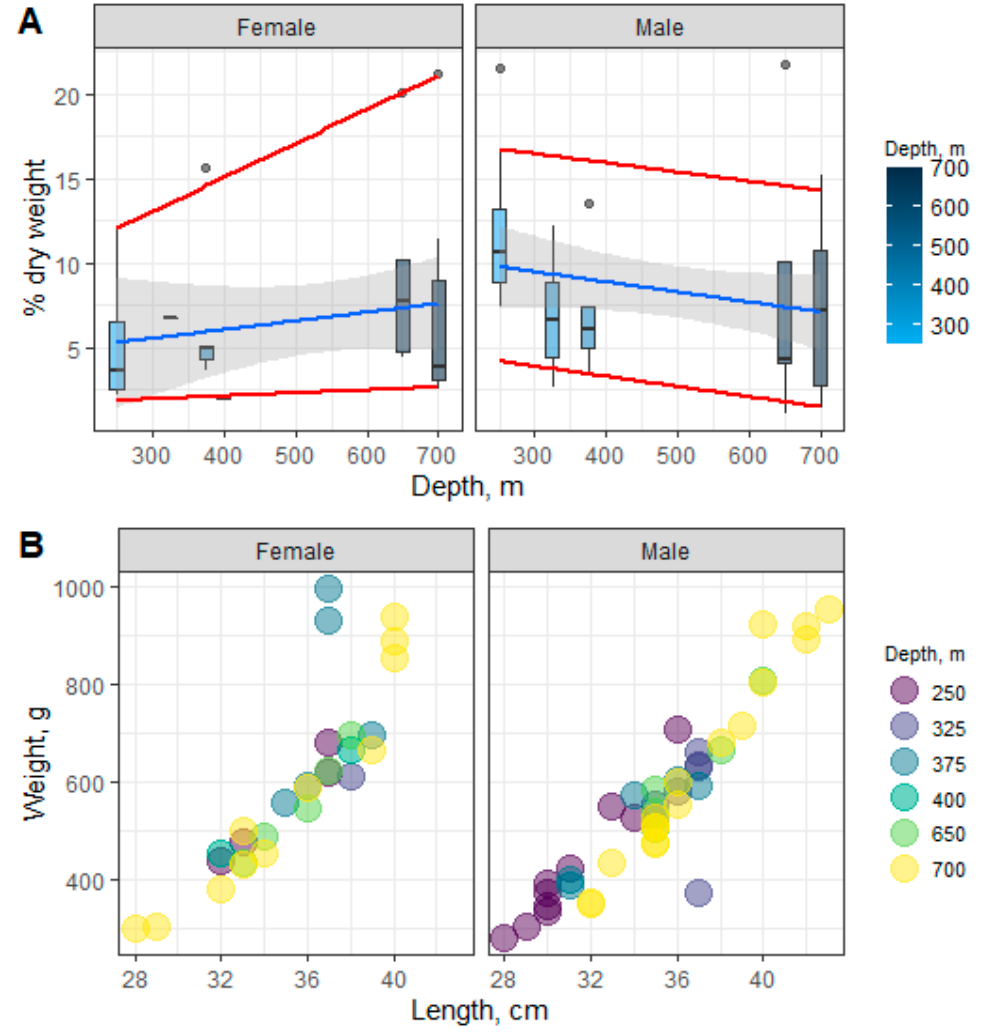
Figure 2. Changes in the content of the total lipids ( A ) and size–weight characteristics ( B ) in male and female beaked redfish, Sebastes mentella, in the depth gradient of the Irminger Sea (North Atlantic).